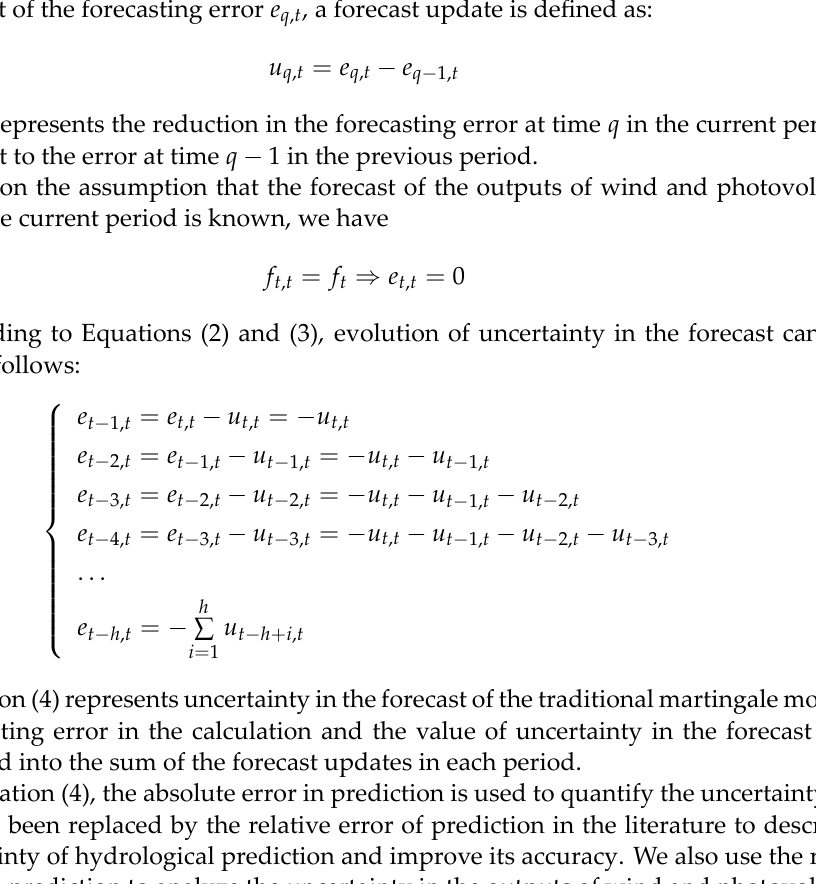
In light of the forecasting error e q , t , a forecast update is defined